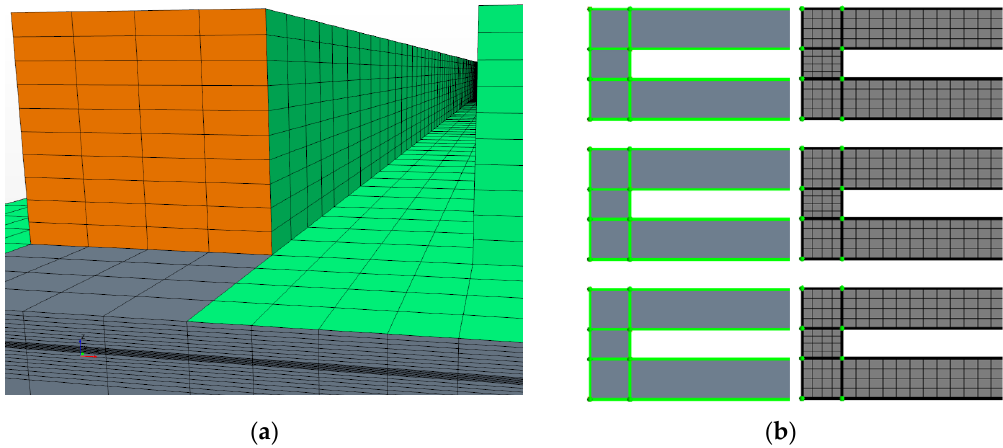
Figure 3. ( a ) Computational Direct mesh of the serpentine. ( b ) Patch mesh of the serpentine.